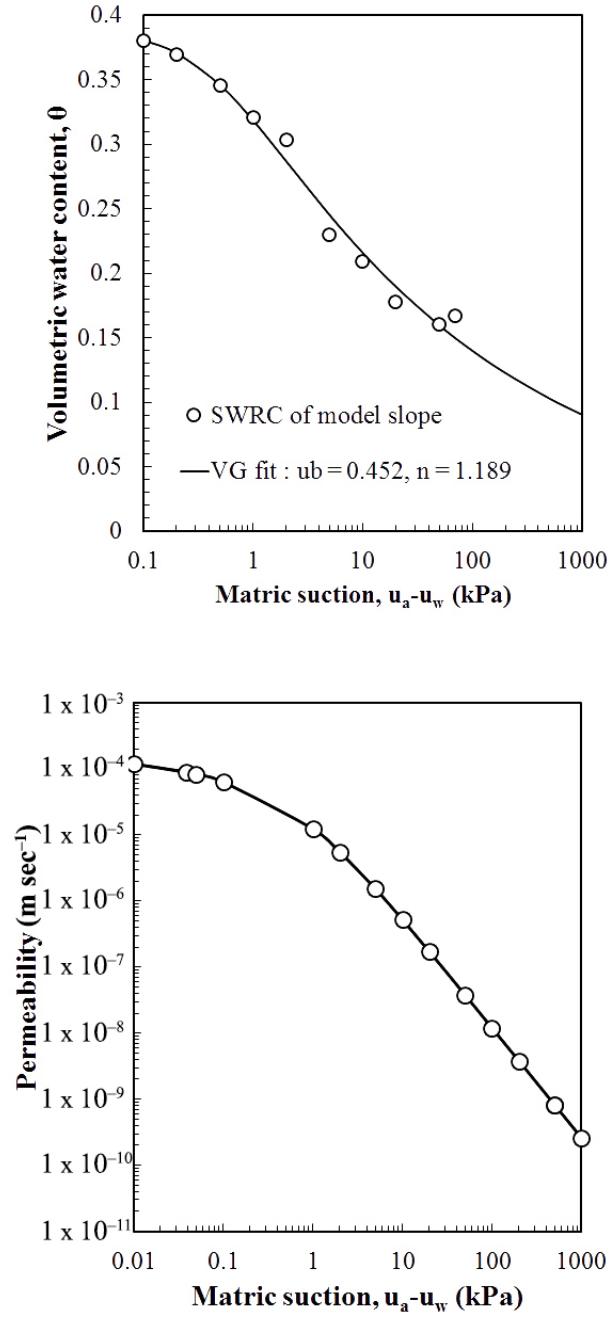
Figure 3. Hydromechanical properties of (a) soil water retention data, (b) hydraulic conductivity function.